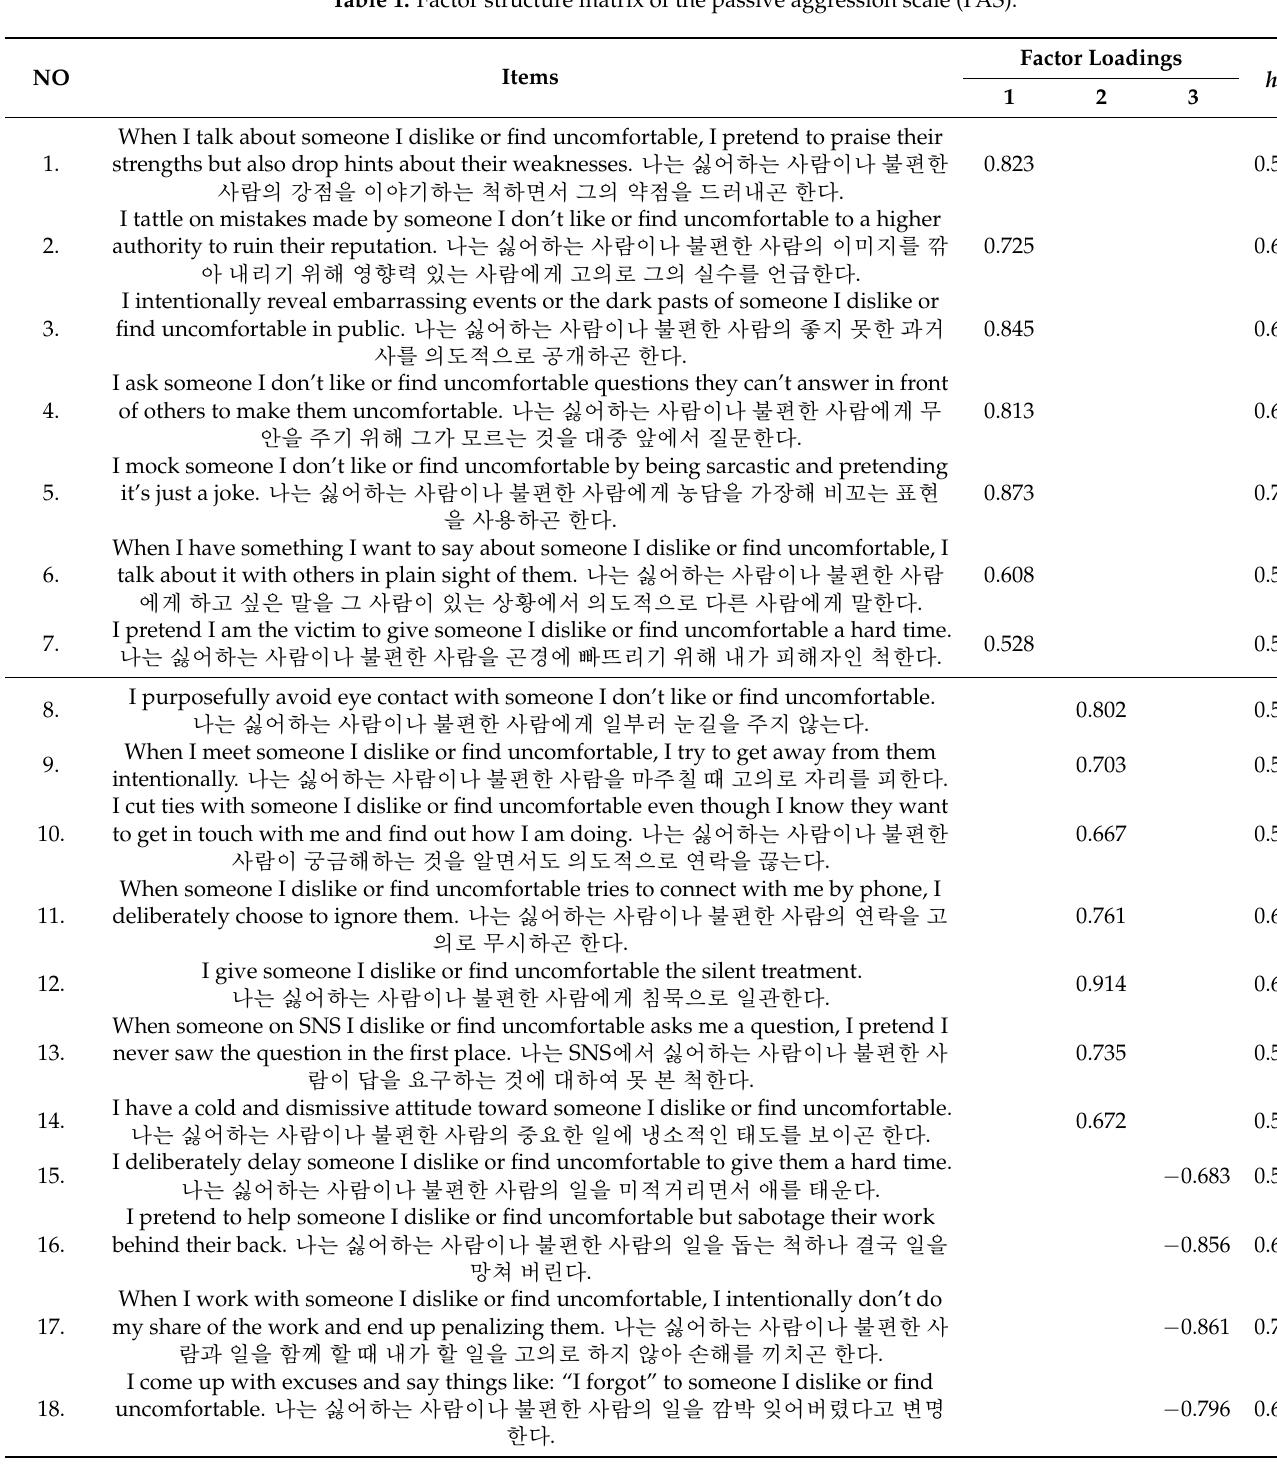
described “avoiding or ignoring,” accounted for an additional 15.2% of the total variance, and the factor loadings ranged from 0.672 to 0.914. Finally, Factor 3, in which the seven items described “sabotaging,” accounted for an additional 9.4% of the total variance, and the factor loadings ranged from − 0.591 to − 0.861. In addition, the absolute values for skewness of the PAS subscales ranged from 0.08 to 1.03 and the absolute values for kurtosis ranged from 0.45 to 0.95, suggesting that they were close to the normal distribution. Table 1. Factor structure matrix of the passive aggression scale